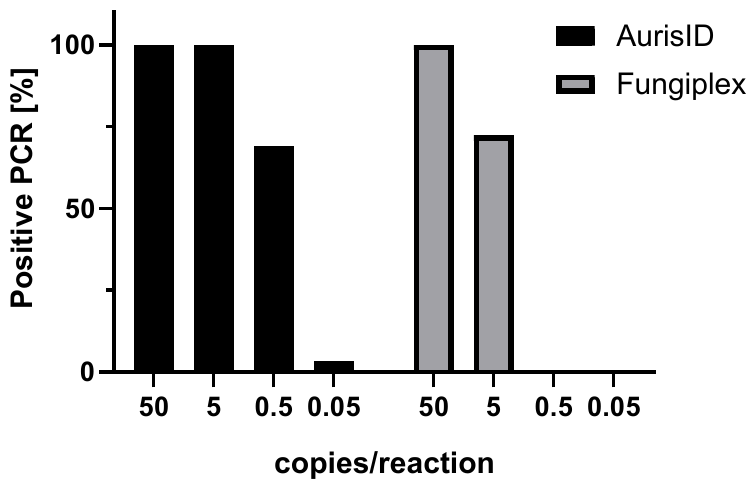
Figure 1. Detection rates of C. auris by Auris ID and Fungiplex CaRT. The assays were challenged with DNA of 29 C. auris isolates at various copy numbers. Table 1. Performance of PCR assays on human blood. Threshold for PCR positivity for two isolates using (a) spiked blood samples and (b) mixed DNA ( C. auris cultures/blood). (a) Viable CFU/Reaction for C. auris ‐ Spiked (b) Copies/Reaction Determined for Isolate Blood Samples Mixed DNA C. auris /Blood